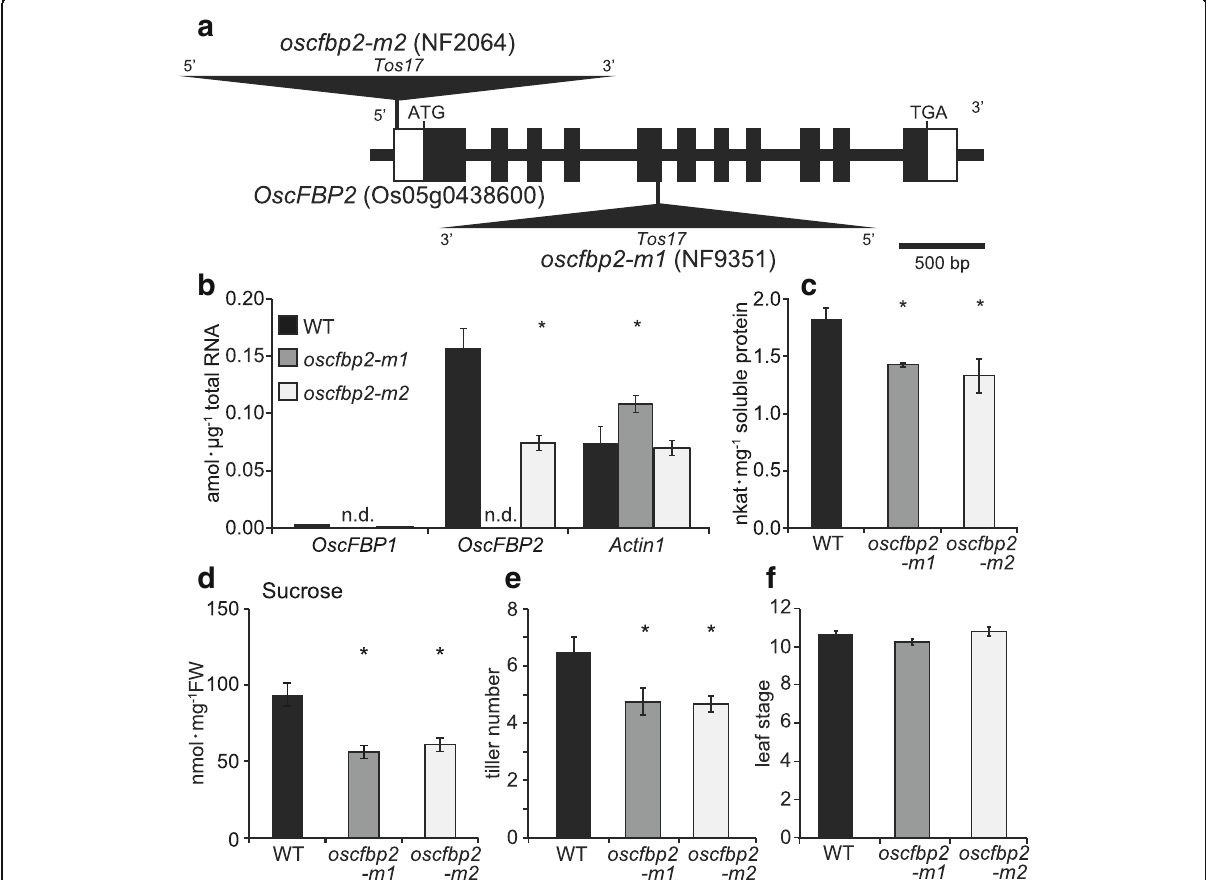
Fig. 6 Isolation and analysis of OscFBP2 rice mutants. a Diagram of the insertion point of the retrotransposon Tos17 (triangle) in the OscFBP2 gene. Exons are indicated as boxed regions, lines represent introns, and open boxes correspond to 5 ′ - and 3 ′ -untranslated sequences. b-d Analyses of gene expression ( b ), cFBPase activity ( c ), and sucrose content ( d ) in the basal portions of the wild-type shoots (WT: black column) and those of two oscfbp2 mutants ( oscfbp2-m1 , gray column; oscfbp2-m2 , open column). Seedlings were grown hydroponically in the presence of 1 mM NH 4 Cl until the fourth leaf stage. e, f Tiller number ( e ) and leaf stage ( f ) of wild-type plants (WT: black column) and two oscfbp2 mutants ( oscfbp2-m1 , gray column; oscfbp2-m2 , open column) at 50 days after germination. Seedlings were grown hydroponically in the presence of 1 mM NH 4 Cl. Mean values plus the SE of five independent plants in ( b-d ) and four independent plants in ( e , f ) are indicated. Asterisks denote statistically significant differences between the WT and each oscfbp2 mutant (*, P < 0.05 by Student ’ s t